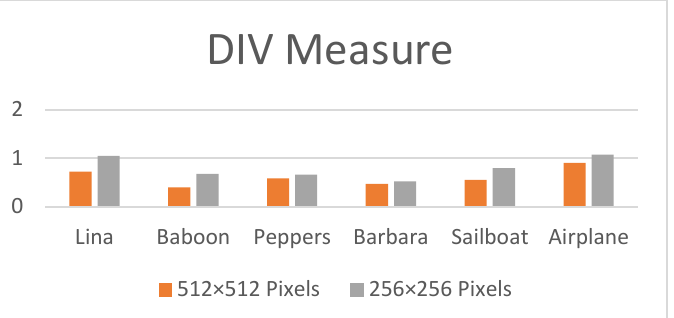
Figure 7. DIV measure for embedding 2000 bytes in colour images of sizes 512 × 512 and 256 × 256.